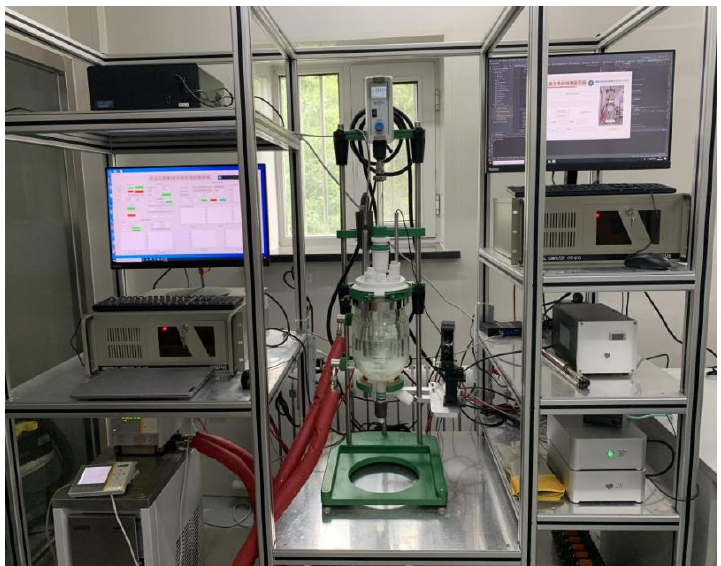
Figure 6. Experimental equipment for batch cooling crystallization processes.